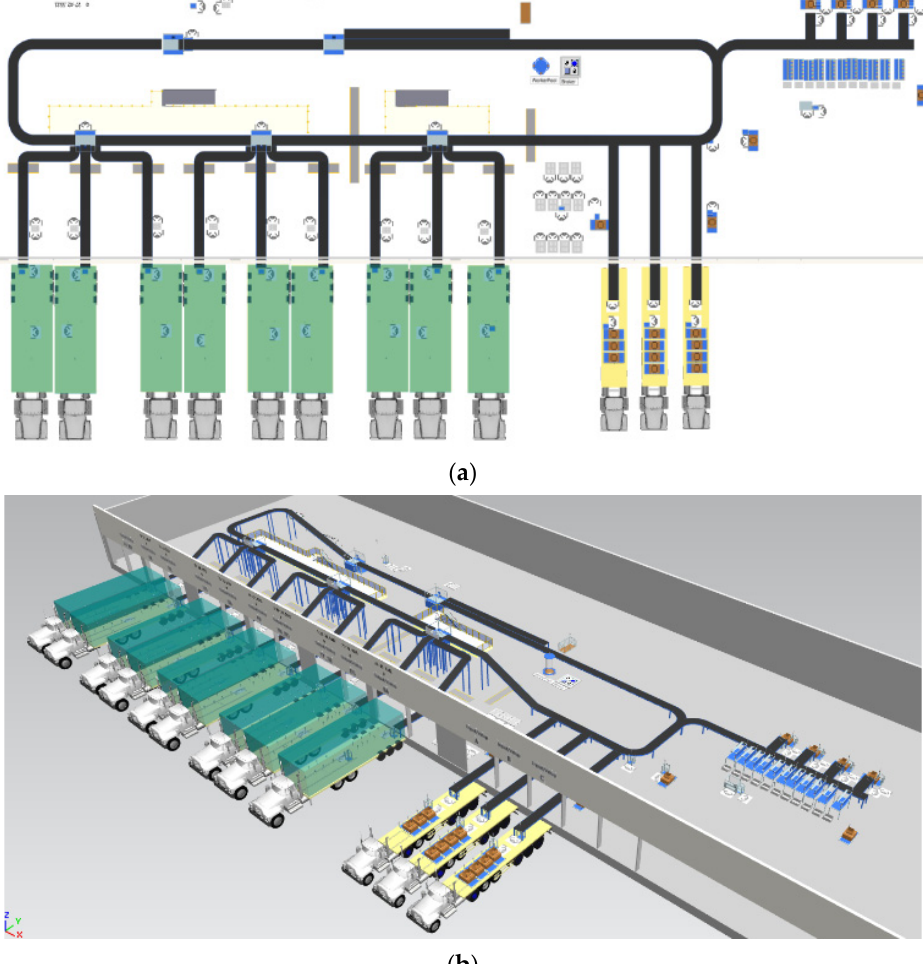
Figure 8. Actual simulation model: ( a ) 2D view; ( b ) 3D view.